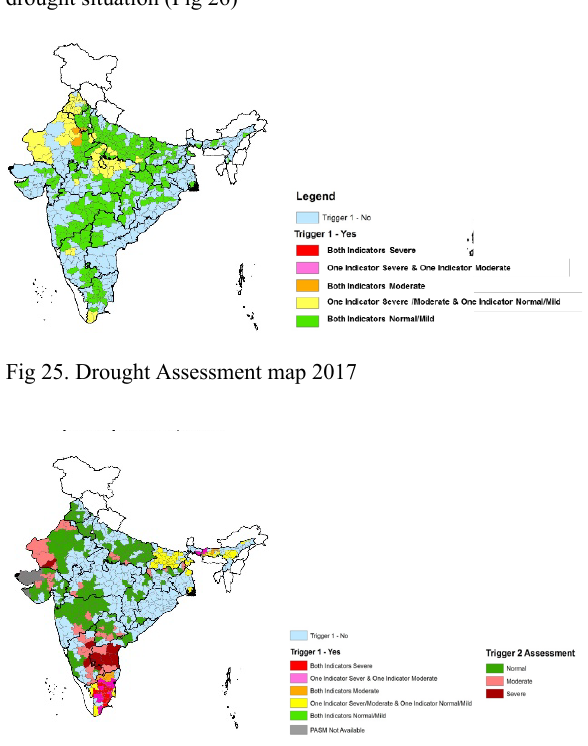
Fig 26. Drought Assessment map 2018 Final drought assessment analysis shown that in Andhra Pradesh, 4 districts Ananthpur, Nellore, Cuddappah and Prakasam are under severe drought condition. In Chhattisgarh and Haryana the drought situation is normal. In Karnataka